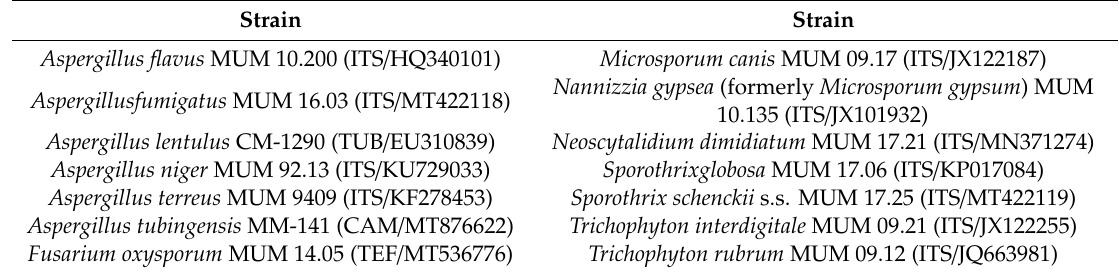
Table 1. Reference strains used in the development of an in-house library. In brackets, the gene region used for the fungal identification and the access number in the